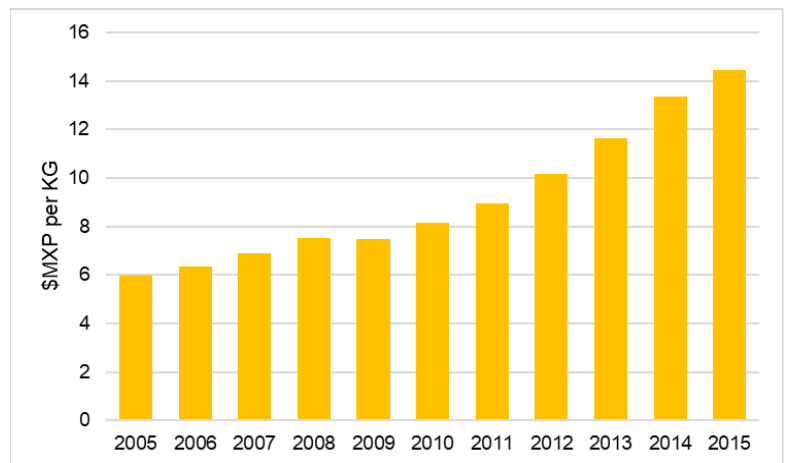
Fig. 4. Propane price in 2015 $MXP, 2005–2015 (SENER,